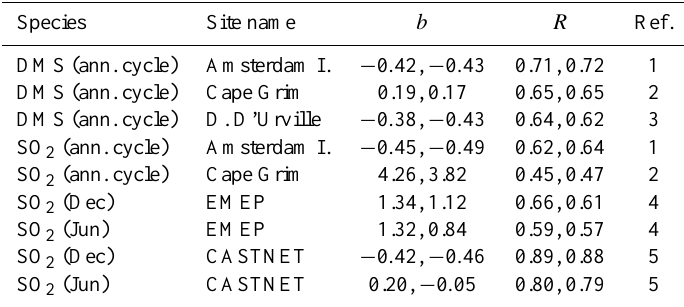
Table 3. Simulated gas phase DMS and SO 2 against surface observations for bin and mode, respectively (comma-separated). Normalised mean bias ( b ) and Pearson correlation coefficient ( R ) are shown for each dataset. References for the observations are 1: Nguyen et al. (1992), 2: Ayers et al. (1991), 3: Jourdain and Legrand (2001) 4: Loevblad et al. (2004) 5: Holland et al. (1999). Species